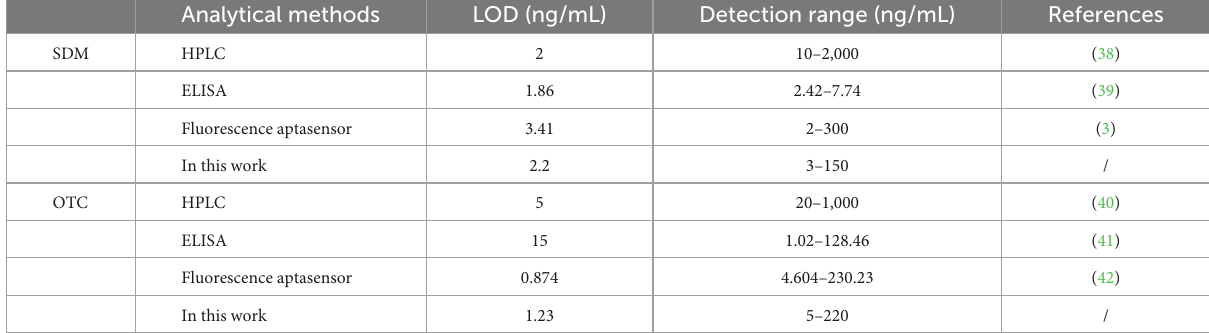
TABLE 2 Recoveries and coefficients of variation of spiked samples and comparison between aptasensor and high performance liquid chromat ography (HPLC) results ( n = 5). Analytical methods LOD